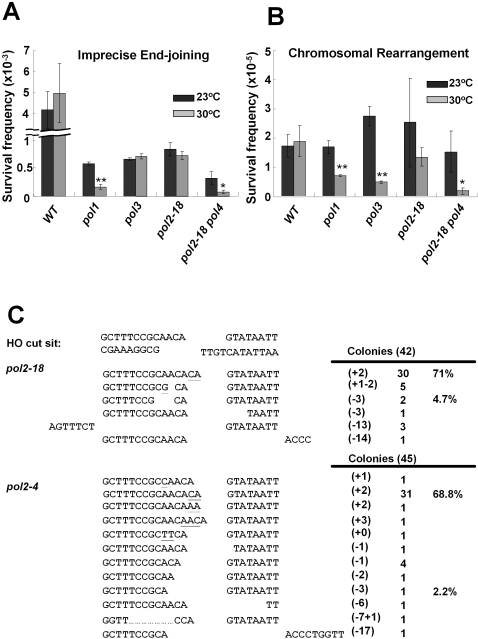
Measurements of NHEJ ability of essential DNA polymerases.The NHEJ assay was performed for pol1, pol3, pol2-18 and pol2-18 pol4 at permissive (23°C) and semi-permissive (30°C) temperatures. (A) Frequencies of imprecise end joining. The survival frequency was evaluated by the ratio of YPGal/YPD. (B) Frequency of chromosomal rearrangement was evaluated by the ratio of FOAR/YPD. Each experiment was collected from at least five independent clones. Dark gray bars indicate 23°C incubation and light gray bars indicate 30°C incubation. *: P<0.05; **: P<0.01. (C) Survivors of pol2-18 or pol2-4 mutants from YPGal plates at 30°C were examined. Bases underlined indicate insertion or mutation. The numbers of inserted (+) and deleted (−) bases were denoted in brackets. N indicates the events of each repair pattern.